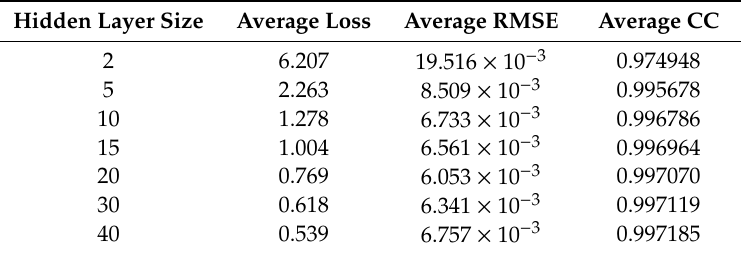
Table 5. E ff ect of the hidden layer size on